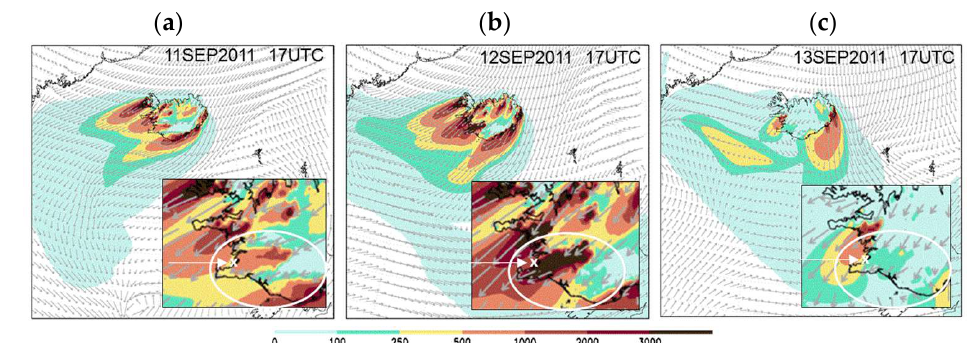
Figure 9. DREAM surface dust concentration (µgm −3 ) forecast for September 2011 dust storm: ( a ) The day before the dust storm peak (11 September at 17UTC); ( b ) at the dust storm peaking hour (12 September 17UTC); and ( c ) the day after dust storm peak (13 September 2011 17UTC). Reykjavik location is marked with “x” and pointed to with a white arrow. Region within the circle is a dust plume zone.